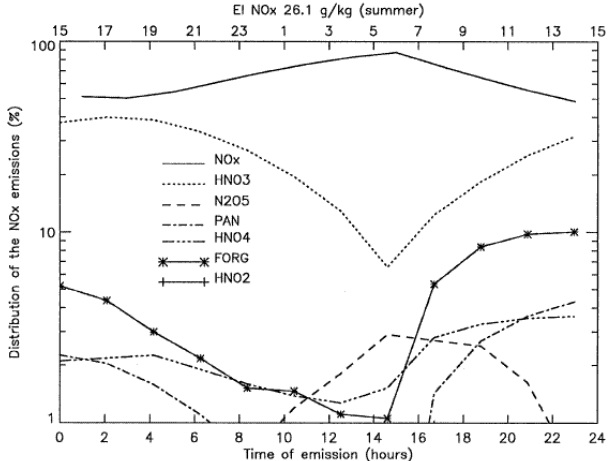
Fig. 14. Distribution of the NO x emissions after 15h as a function of emission time for a summer situation at 50 ◦ N. The upper axis gives the time after τ = 15h of integration. FORG=CH 3 O 2 NO 2 + CH 3 ONO 2 + C 2 H 5 ONO 2 + C 4 H 9 ONO 2 and is the sum of the oxy- and peroxynitrates included in the kinetic scheme. Reprinted from Kraabøl et al. (2000b), Atmospheric Environment, Copyright (2000), with permission.